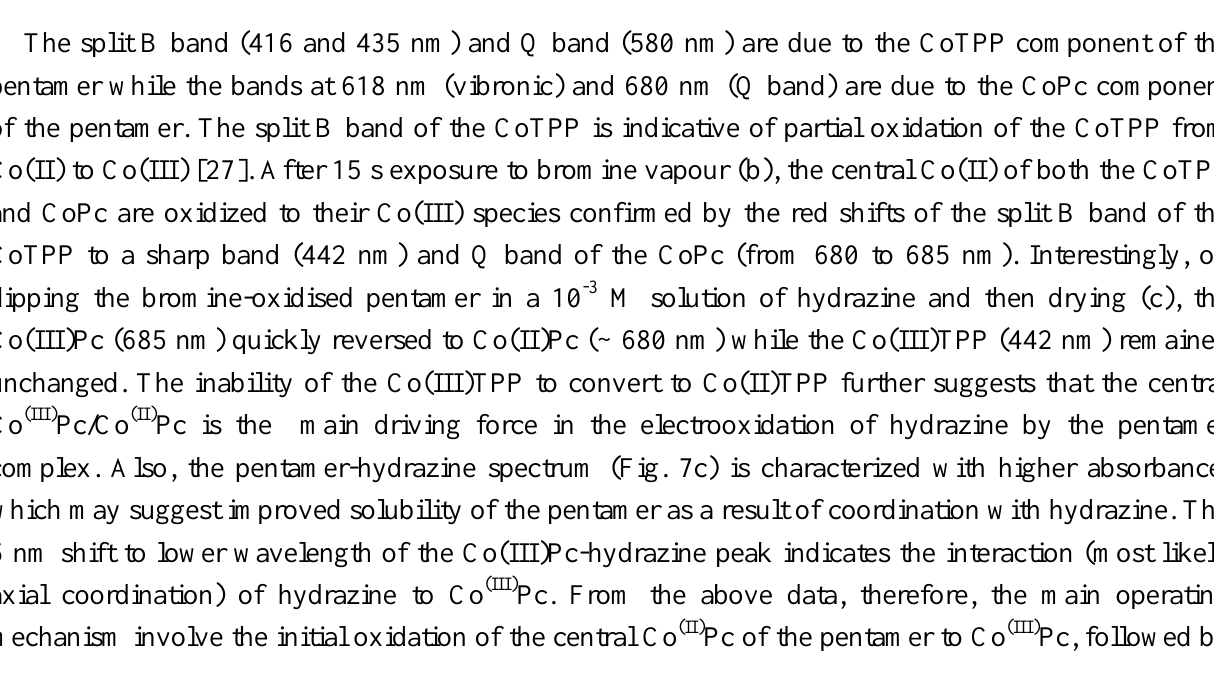
Figure 7: UV-Visible spectra of CoPc-(CoTPP) exposure to bromine vapour (b) and dipping in 0.1 M NaOH solution of hydrazine solution and drying